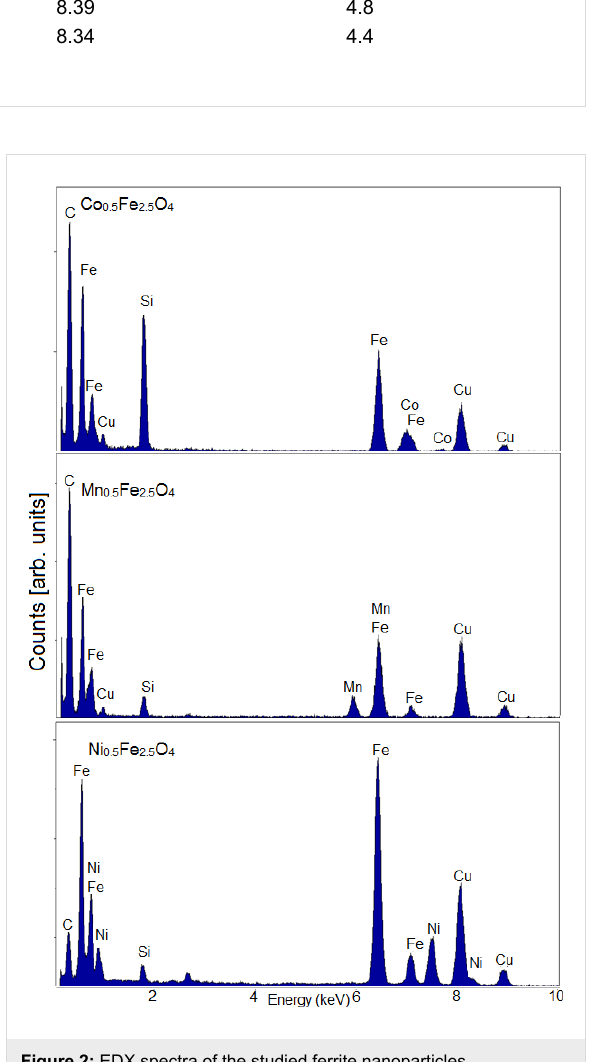
Figure 2: EDX spectra of the studied ferrite nanoparticles.